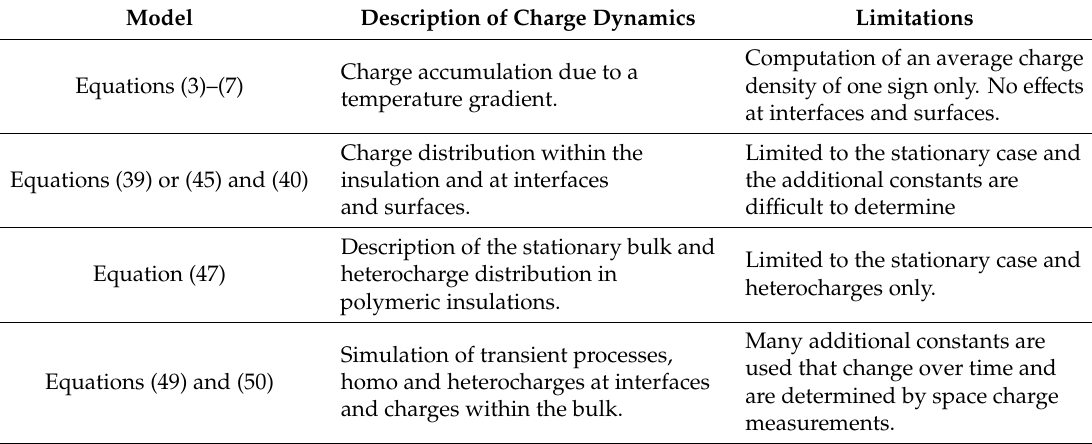
Table5. Comparisonofdi ff erentconductivitymodelsandtheirdescriptionofspacechargeaccumulation within the